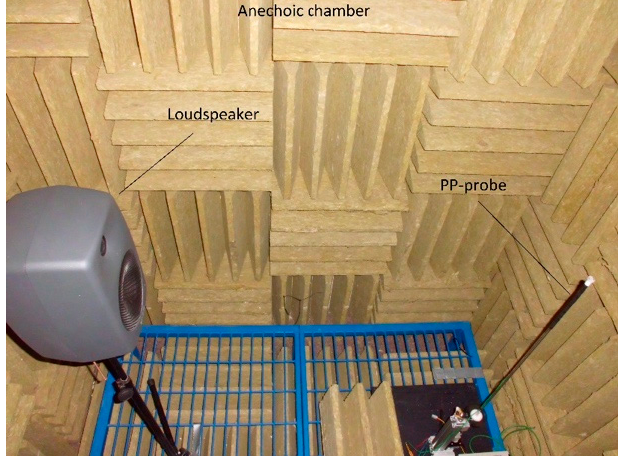
Figure 2. Construction details of the header of the mechatronic 2D sound intensity probe based on two microphones.